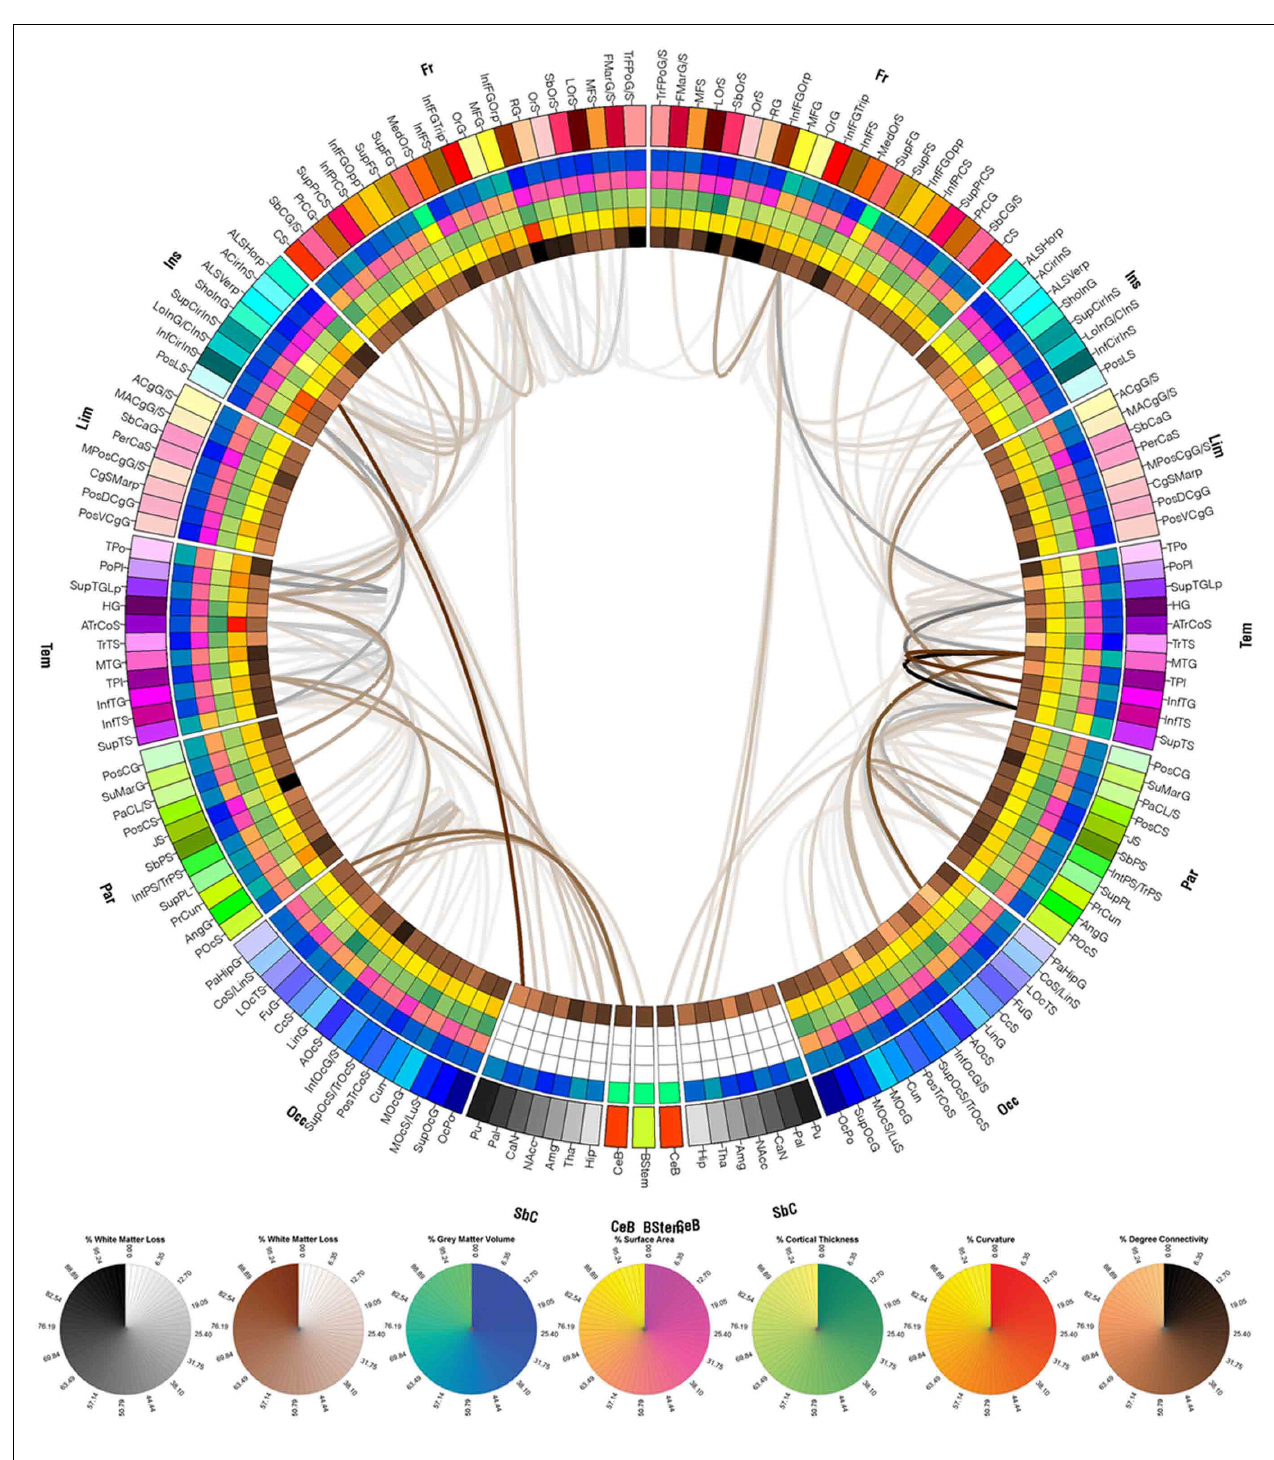
FIGURE 6 |As in Figure 4, for patient